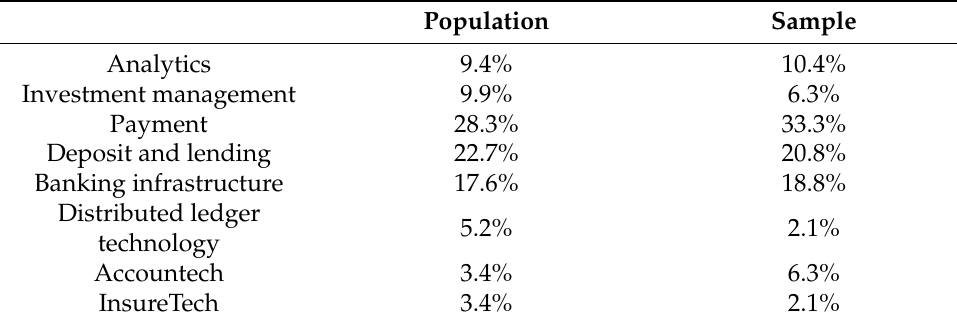
Table 2. Comparison of the sample and population